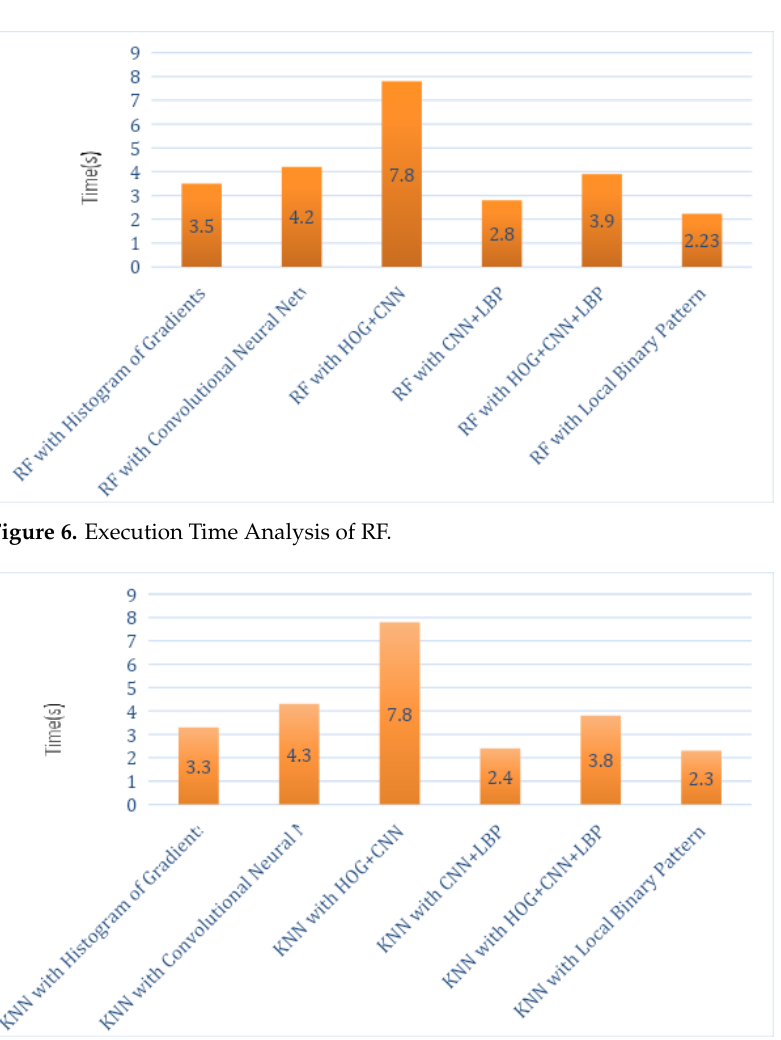
Figure 7. Execution Time Analysis of